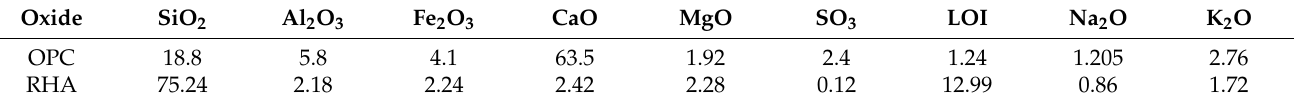
Table 1. Chemical constituents (%) of RHA and